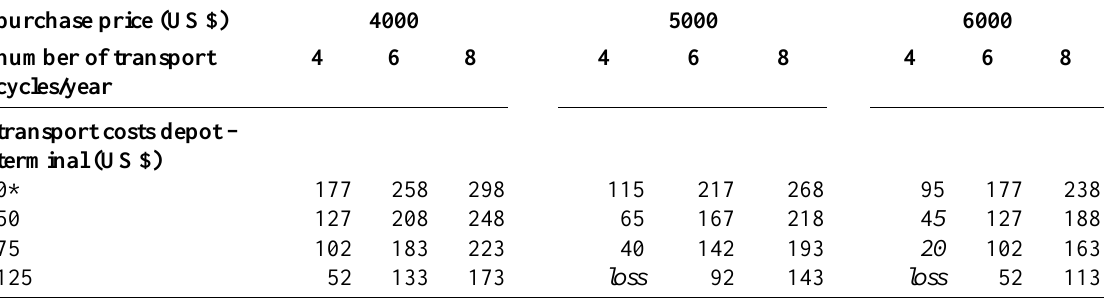
Table A2. Break-even costs (in US dollars) for folding and unfolding a container for different purchase prices of foldable containers, turnaround rates (# cycles/year) and costs for transport from depot to terminal purchase price (US